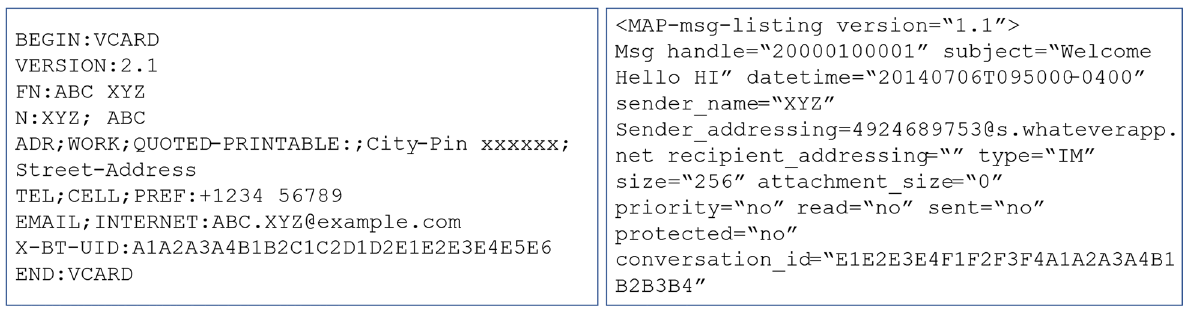
Fig. 5 Example vCard format (left) and message format